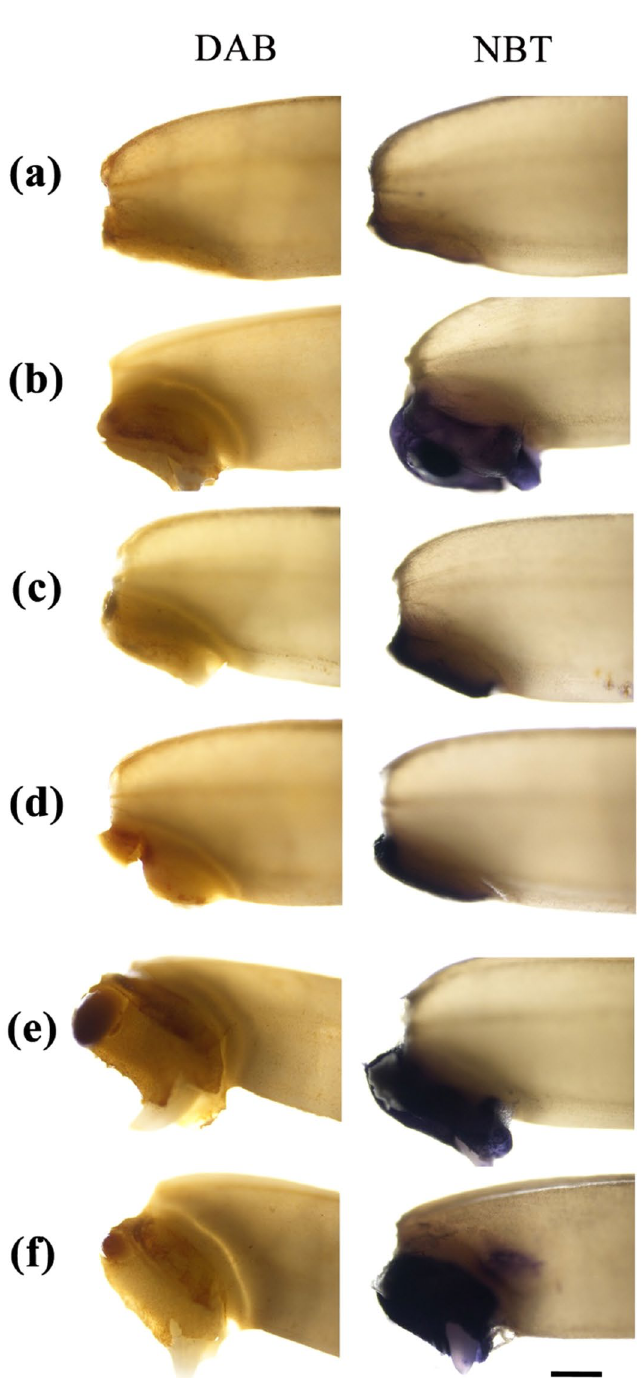
Figure 9. Histochemical localization of H 2 O 2 and O 2 • – in rice seeds imbibed for 36 h using DAB ( a ) and NBT ( b ) staining, respectively. Representative bright field images of imbibed seeds of ( a ) unprimed control, ( b